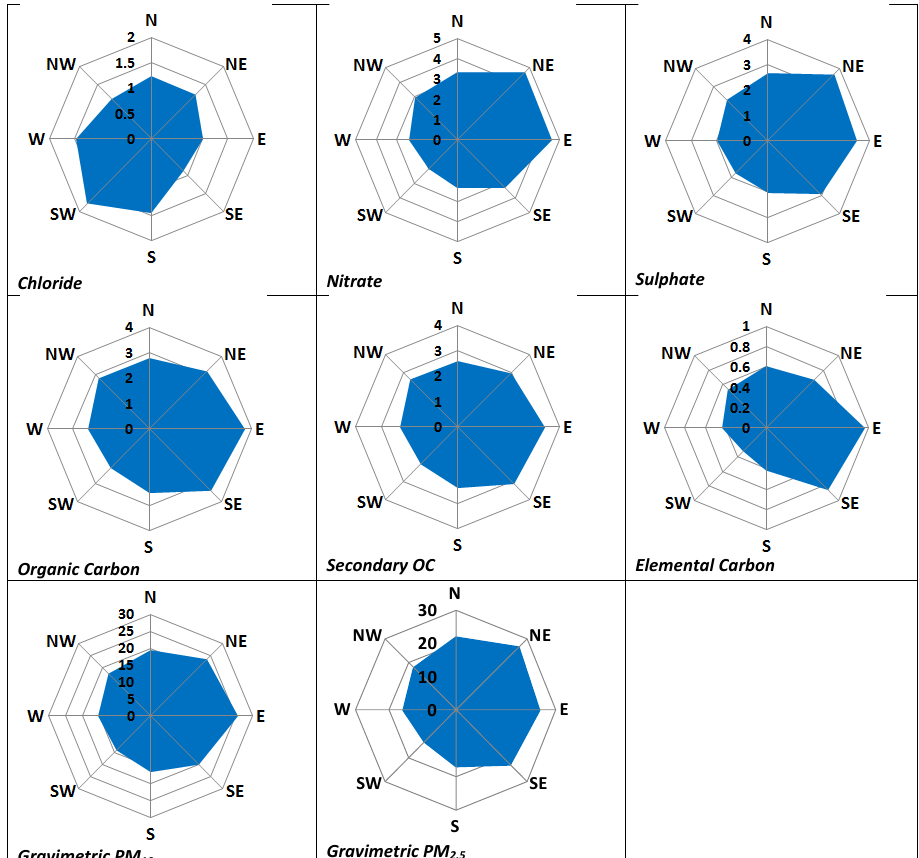
Fig. 2. Median concentrations per wind sector inµgm − 3